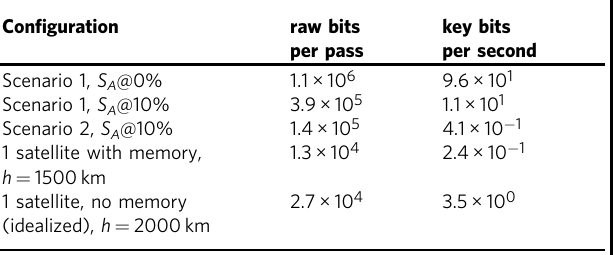
Table 2 Effective rates for multiple con fi gurations of orbiting